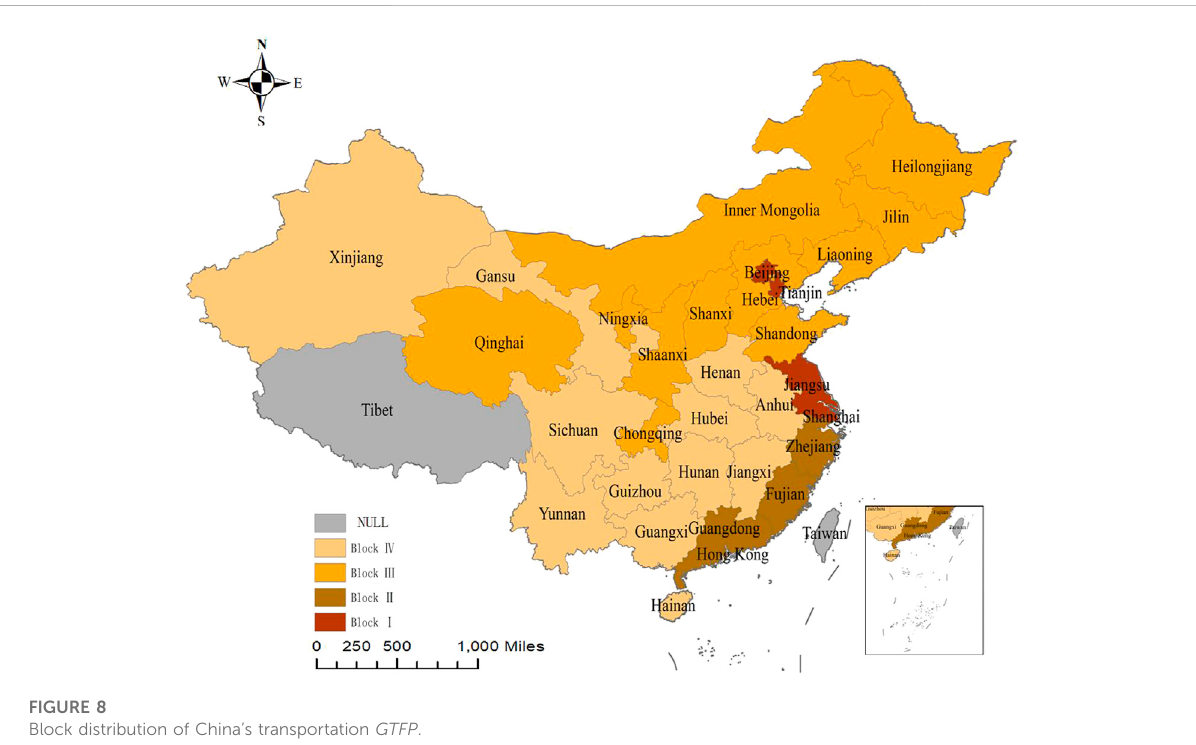
FIGURE 8 Block distribution of China ’ s transportation GTFP .